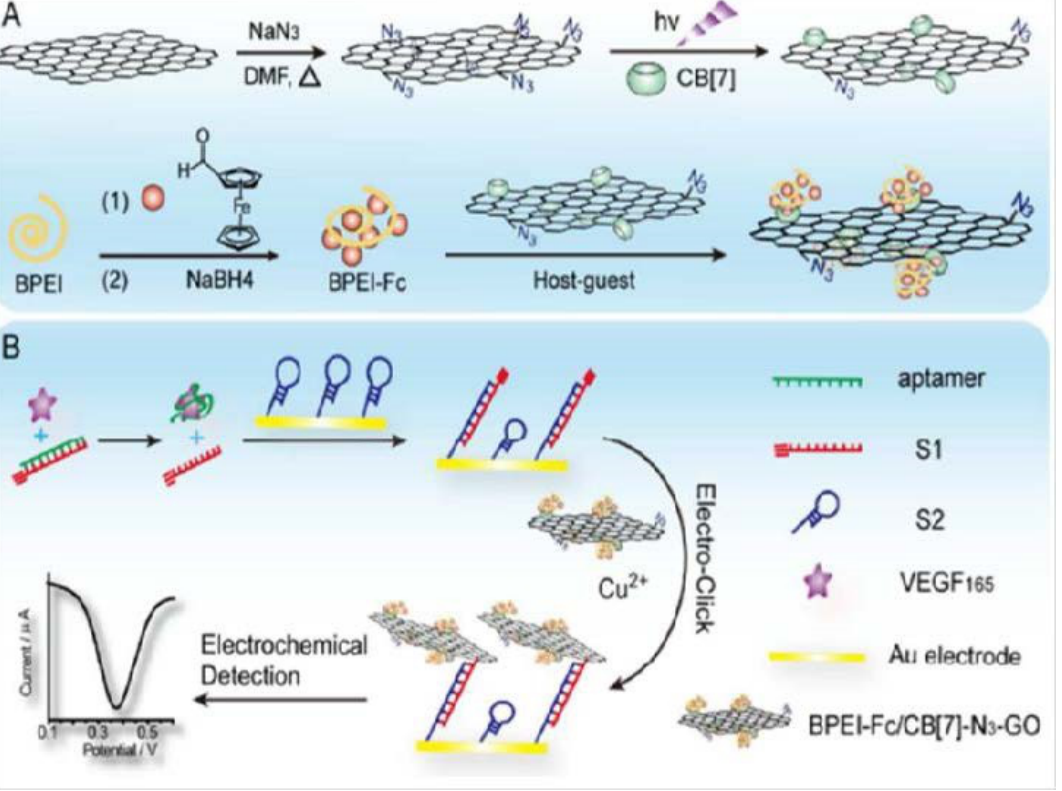
Figure 8. Preparation of BPEI-Fc-CB[7]-N 3 -GO composite ( A ) and schematic illustration of the electroclick biosensing platform constructed for the determination of VEGF165 ( B ). Reprinted from